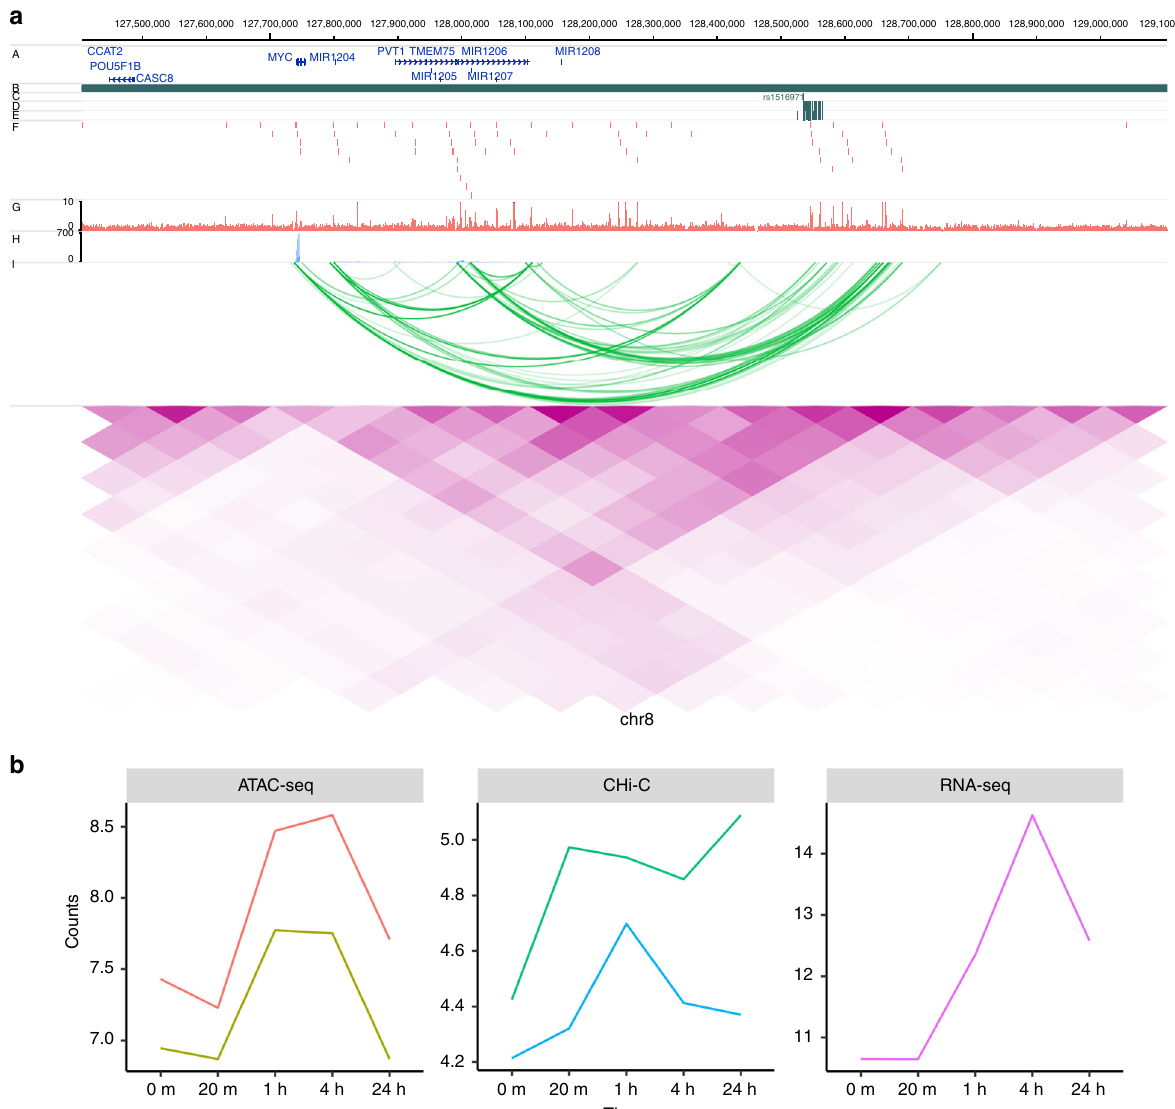
Fig. 5 Illustration of genomic interaction activities around MYC. a Screenshot of the SNPs (dark green), ATAC-seq peaks (red), RNA-seq (lightblue), CHi-C interactions (green) and heatmap from Hi-C (purple) around MYC at time 4 h. y -axis labels A – J represent different tracks plotted. A RefSeq genes, B TADs, C Index SNPs, D LD SNPs, E 99% credible sets, F ATAC-seq peaks, G ATAC-seq signal, H RNA-seq, I CHi-C, J Hi-C. b Time course pro fi les of ATAC-seq (left), CHi-C (middle) and RNA-seq (right) of the data associated with SNPs data around